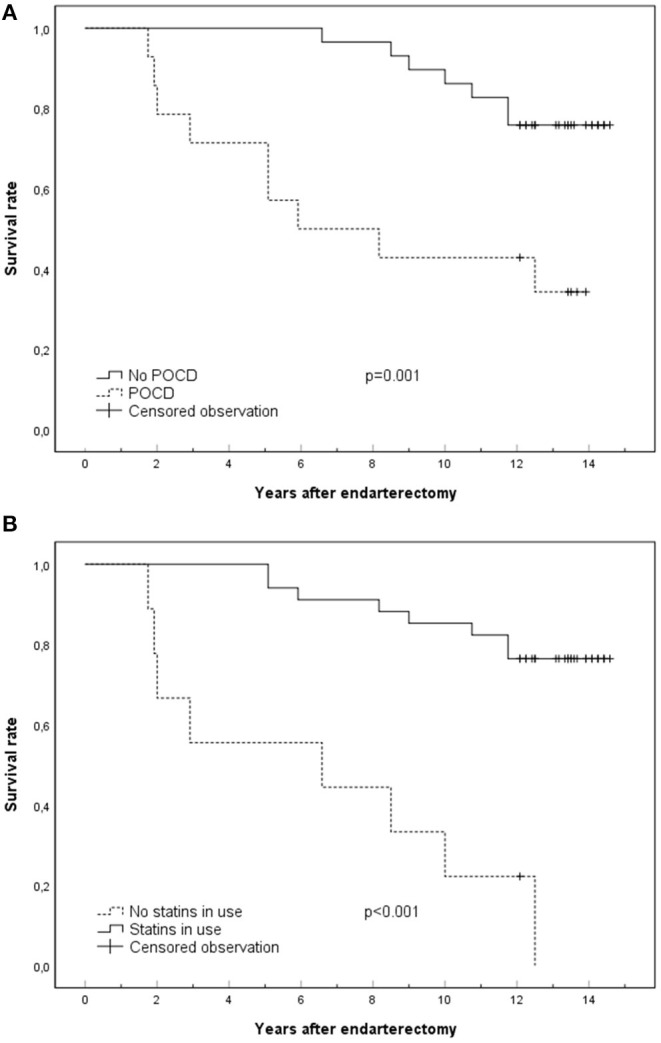
Kaplan–Meier curves presenting major factors that affect survival: POCD at 3 months (A) and statin use at the time of death or end of follow-up (B). Censored observations are surviving patients at the end of follow-up. POCD, postoperative cognitive dysfunction.